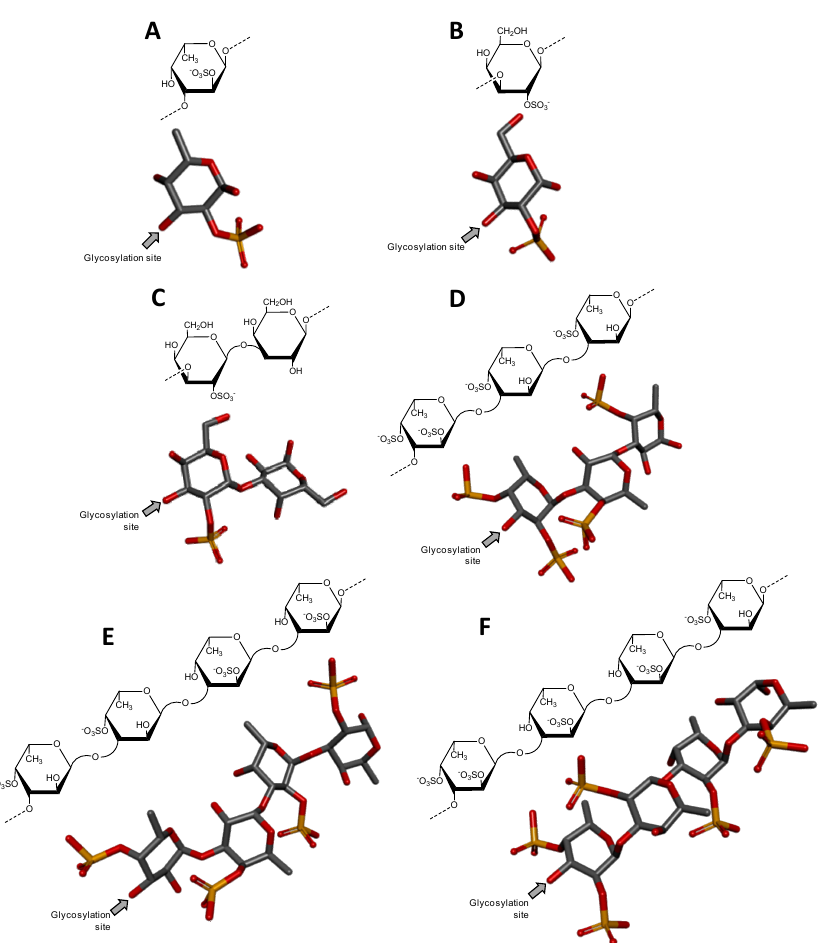
Figure 5. Haworth projections and stick model representations of the repetitive oligosaccharide units of sulfated fucans and sulfated galactans from echinoderms (sea urchins). While ( A ) Strongylocentrotus franciscanus expresses a sulfated fucan composed of 3-linked 2-sulfated α -fucose (Fuc) units [65]; ( B ) Echinometra lucunter synthesizes a sulfated galactan composed of 3-linked 2-sulfated α -galactose (Gal) units [66]. ( C ) The sulfated galactans isolated from Glyptocidaris crenularis is composed of [Gal2S-( α 1 → 3)-Gal] whose non-sulfated Gal unit is also ( α 1 → 3)-linked to the Gal2S of the next disaccharide unit [67]. ( D ) The sulfated fucan-II from Strongylocentrotus purpuratus is composed of [Fuc2,4S-( α 1 → 3)-Fuc4S-( α 1 → 3)-Fuc4S] whose 4-sulfated Fuc unit of the reducing end is also ( α 1 → 3)-linked to the Fuc2,4S of the next trisaccharide unit [68]. ( E ) The sulfated fucan isolated from Strongylocentrotus pallidus is composed of [Fuc4S-( α 1 → 3)-Fuc4S-( α 1 → 3)-Fuc2S-( α 1 → 3)-Fuc2S] whose 2-sulfated Fuc unit of the reducing end is also ( α 1 → 3)-linked to the Fuc4S of the next tetrasaccharide unit [69]; ( F ) The sulfated fucan isolated from Lytechinus variegatus is composed of [Fuc2,4S-( α 1 → 3)-Fuc2S-( α 1 → 3)-Fuc2S-( α 1 → 3)-Fuc4S] whose 4-sulfated Fuc unit is also ( α 1 → 3)-linked to the Fuc2,4S of the next tetrasaccharide unit [70]. Hence, these marine sulfated glycans are regularly composed of monosaccharide ( A , B ); disaccharide ( C ); trisaccharide ( D ) and tetrasaccharide ( E , F ) building blocks. The colors of the atoms used in the representations are grey for carbon, blue for nitrogen, red for oxygen and yellow for sulfur. The hydrogen atoms were omitted for visual simplification. The arrows labeled as “Glycosylation site” indicate the position of the glycosidic bond. Structures were created using ChemDraw Ultra 8.0 for Haworth projections and submitted to MM2 force-field. Then, Discovery Studio Visualizer v.4.5 software (BIOVIA, Dassault Syst è mes) was used for 3D representations after energy minimization. The monosaccharides are displayed in their commonest chair configurations: 1 C 4 for Fuc and 4 C 1 for